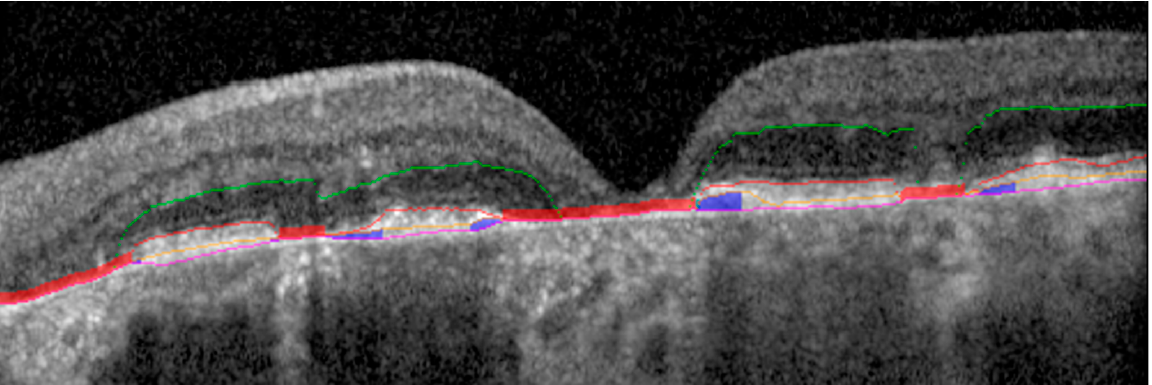
Figure 2. OCT B-scan showing multi-layer segmentation. From top to bottom: ONL (green line); EZ (red line); RPE (orange line); BM (pink line). Regions of GA (red overlay); regions of EZ At-Risk (blue overlay). OCT: optical coherence tomography; ONL: outer nuclear layer; EZ: ellipsoid zone; RPE: retinal pigment epithelium; BM: Bruchs membrane; GA: geographic atrophy.